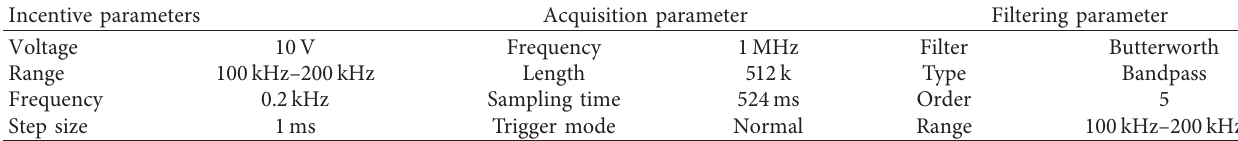
Table 2: The parameters of signal acquisition and filtering.